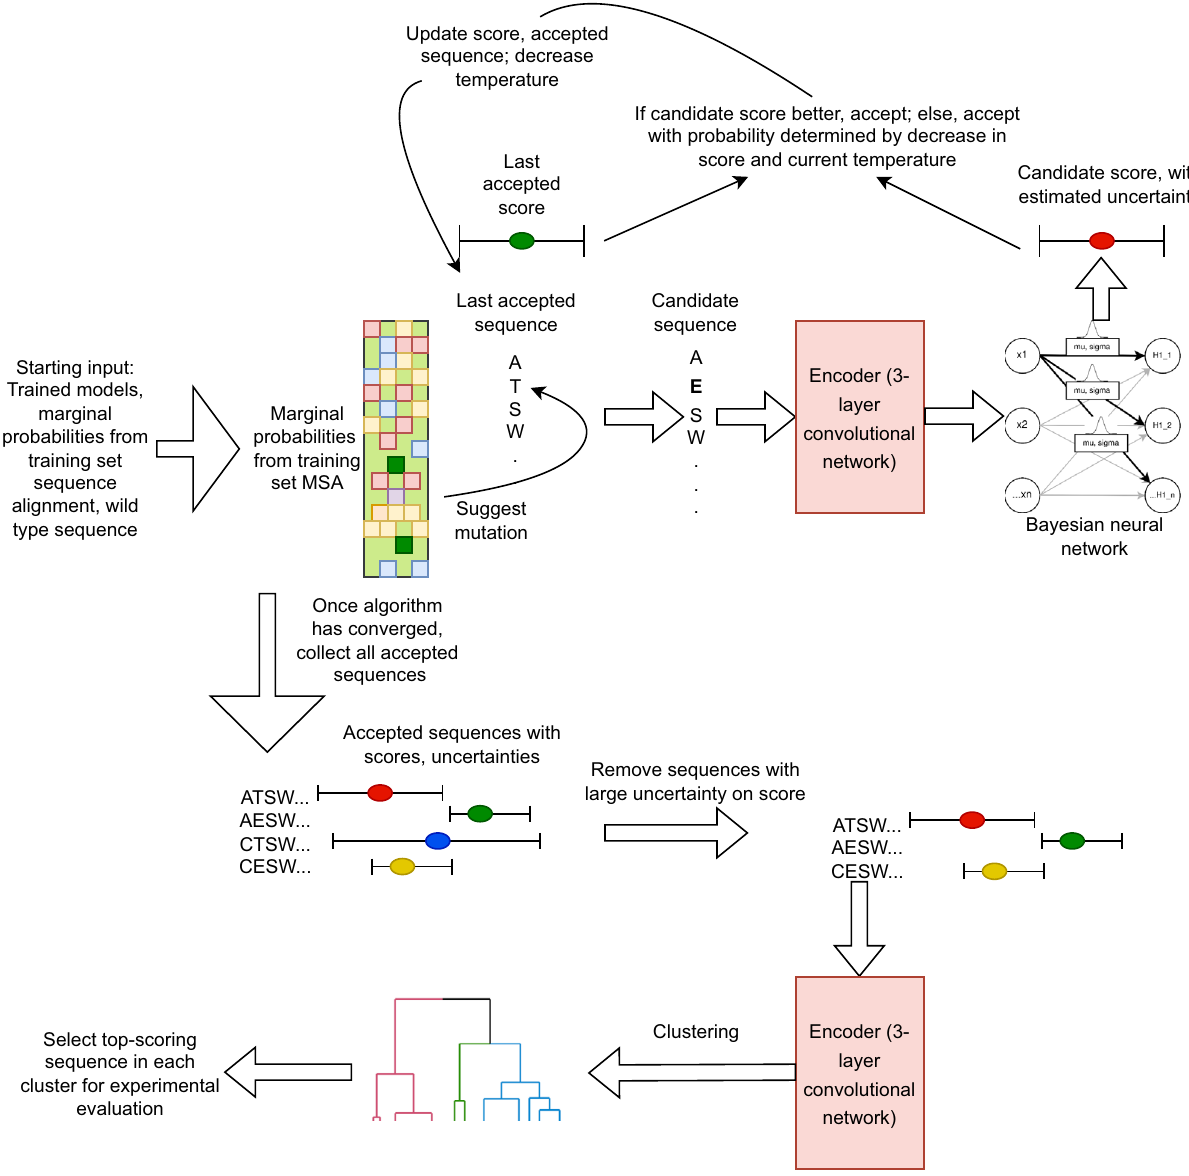
Fig. 3 | Overview of the RESP pipeline. In silico directed evolution using approximate Bayesian inference and learned embeddings for ef fi cient candidate sequence